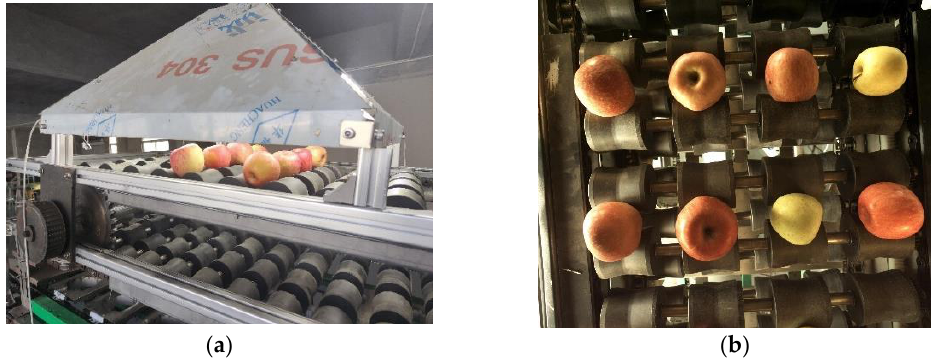
Figure 6. Data set production. ( a ) Image acquisition devices; ( b ) Image acquisition.